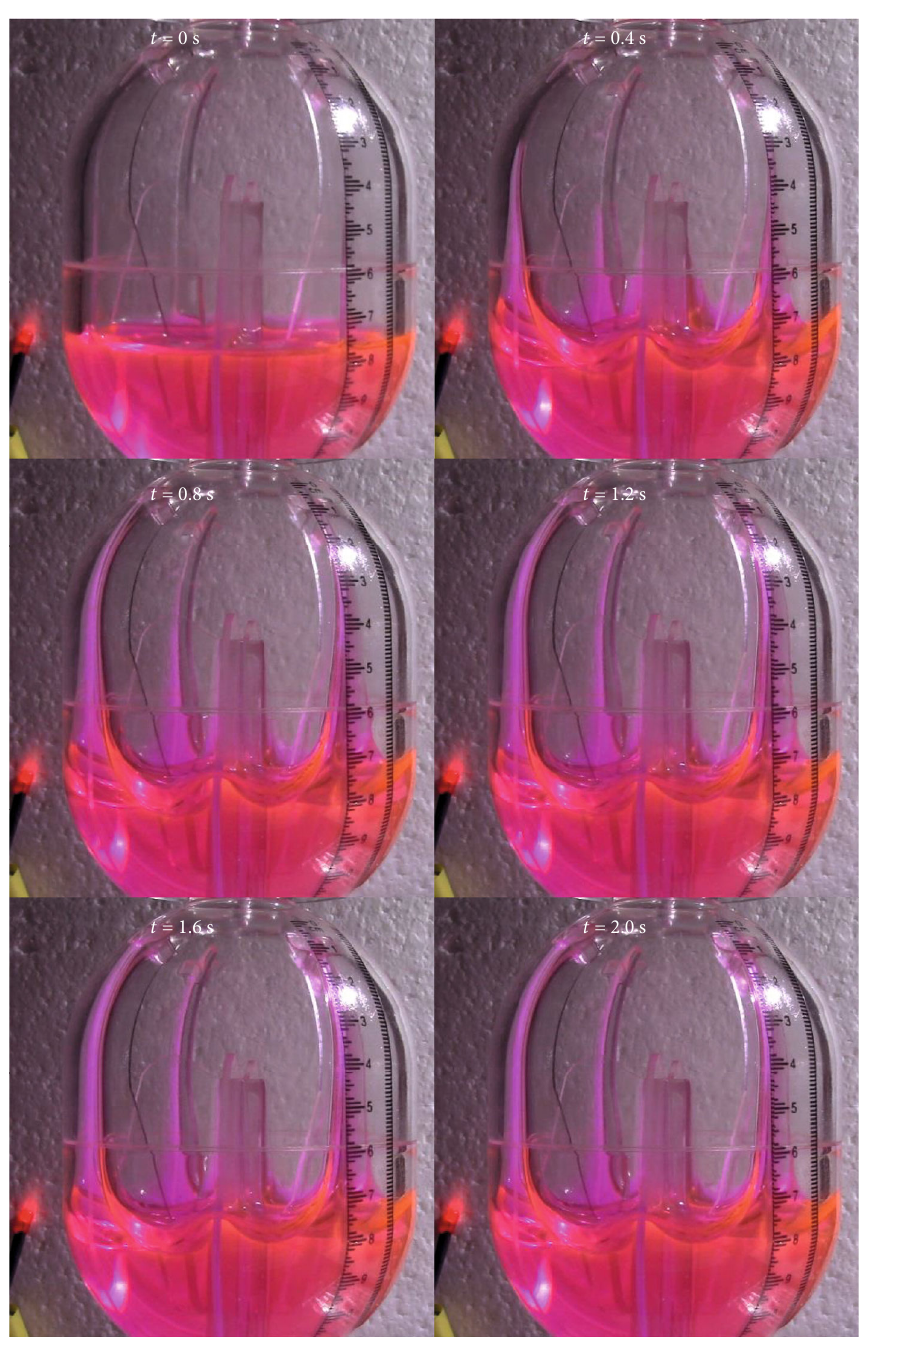
Figure 7: Liquid volume fraction is